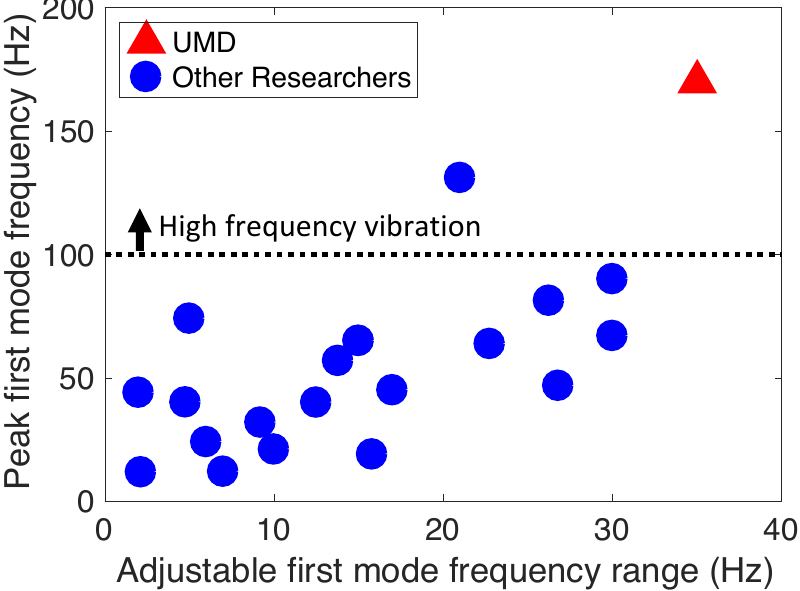
Figure 1. Peak first mode frequency versus adjustable first mode frequency range of a target system of most reported studies on adaptive MRE-DVAs (refer to Table 1). Here, “UMD” implies this Table: Comparison on Peak first mode frequency and adjustable first mode frequency range of a target system using MRE-based DVAs.